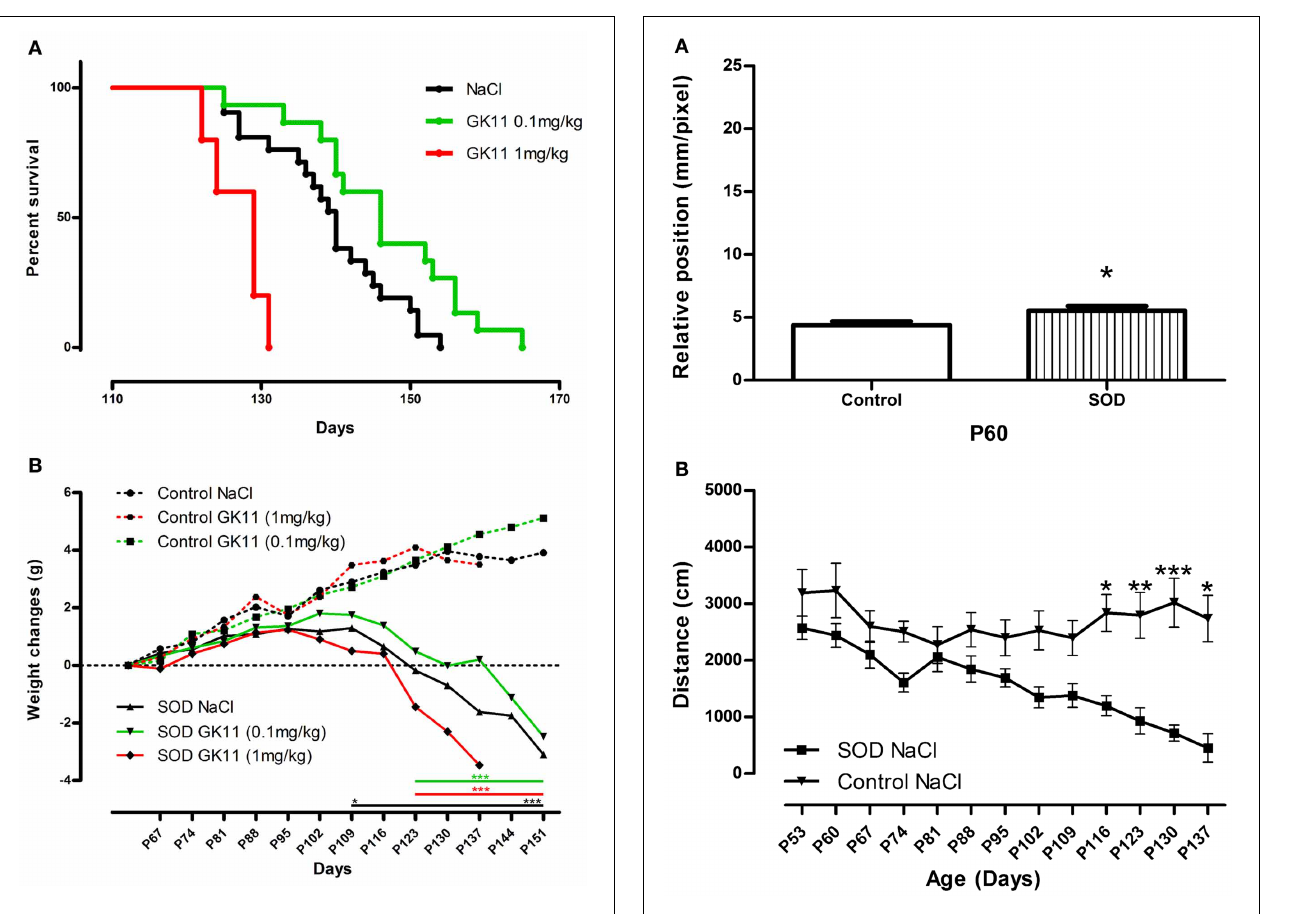
FIGURE 2 | Locomotor function analysis of hSOD1 G93A female mice. (A) —CatWalk gait analysis. Graph represent the distance between the front and hind paws on a step sequence (“relative position”) of control females ( n = 32) and hSOD1 G93A animals ( n = 41) before treatment. Statistics: t -test: * p < 0 . 05 (B) —Open field test. Spontaneous locomotor activity represented by the mean distance covered by control female and hSOD1 G93A mice in a weekly 8min recording test over disease progression. For Open field test a minimum of 10 animals were used from day 53 to 130, then due to the death of hSOD1 G93A mice, a minimum of 5 animals were analyzed (P137). Statistics: two ways ANOVA followed by Tukey Kramer test. F ( 12 , 262 ) = 95 . 95 . ∗ p < 0 . 05, ∗∗ p < 0 . 01 and ∗∗∗ p < 0 .